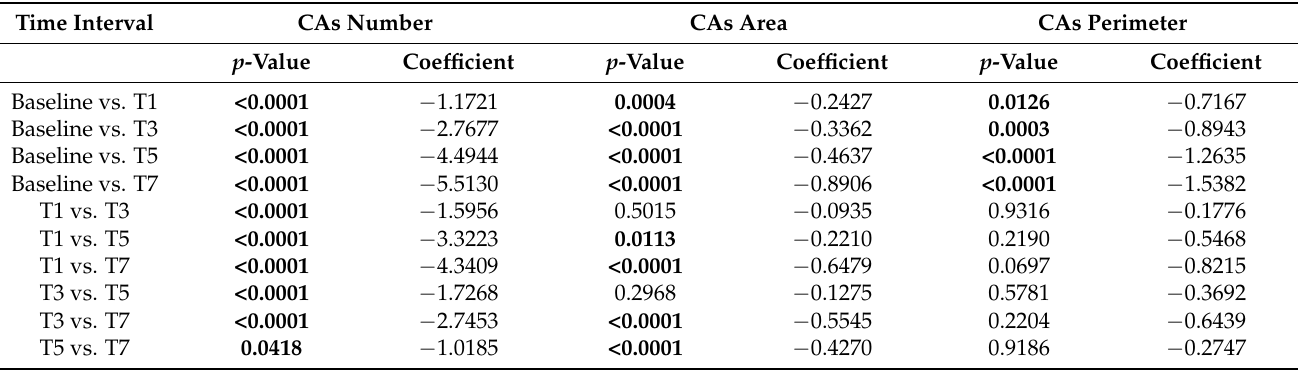
− 4.4944 <0.0001 − 0.4637 −